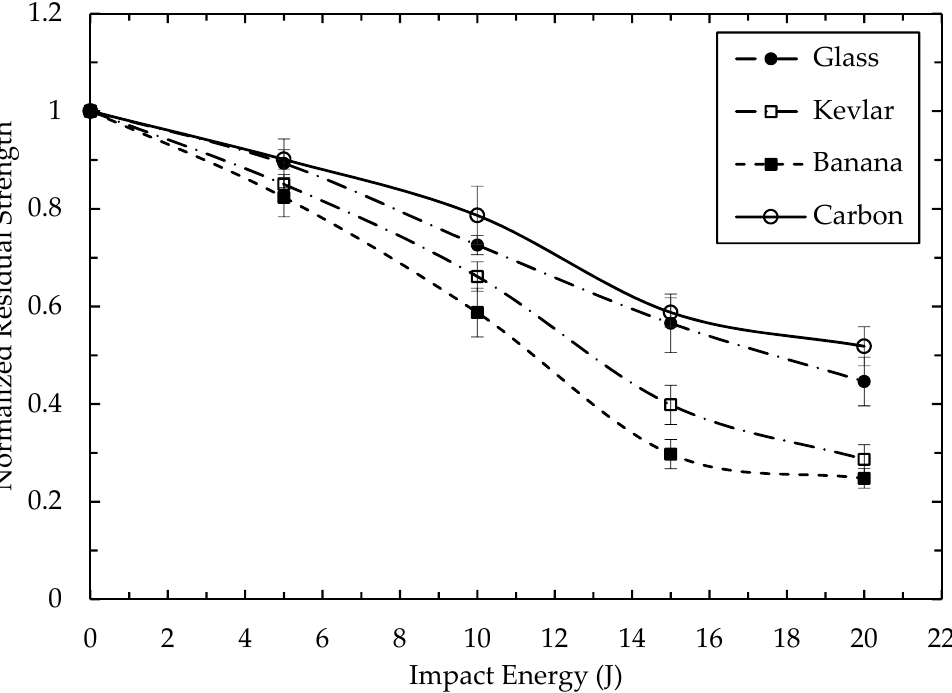
Figure 13. Normalized residual strength as a function of incident impact energy.